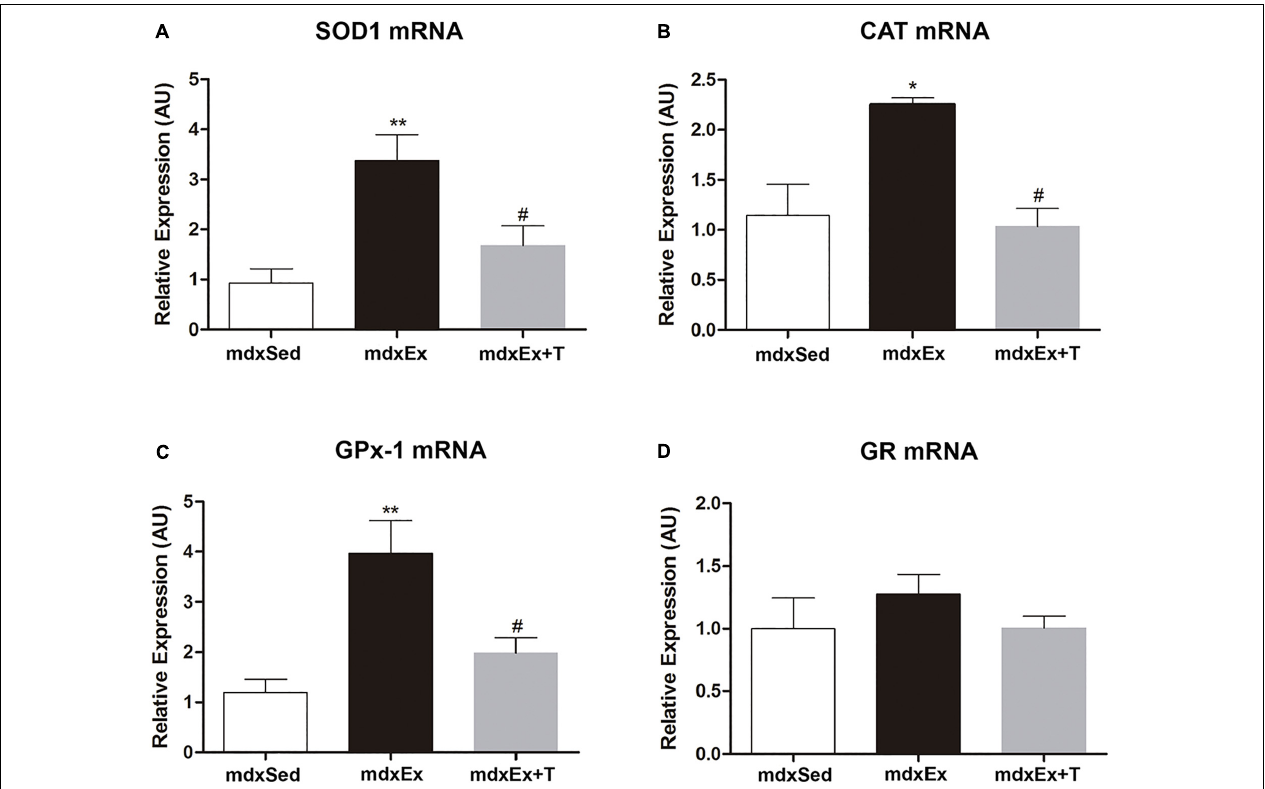
FIGURE 7 | Tempol effects on the enzymatic antioxidant system expression. Gene expression of (A) manganese-superoxide dismutase (SOD), (B) catalase, (C) glutathione peroxidase (GPx), and (D) glutathione reductase (GR) measured by qRT-PCR in the diaphragm (DIA) muscle from the sedentary mdx mice (mdx Sed), exercise trained mdx mice ( mdx Ex), and exercise trained mdx mice treated with Tempol ( mdx Ex+T). All values expressed as mean ± standard deviation (SD). * P ≤ 0.05 compared with the mdx Sed group, ** P ≤ 0.001 compared with the mdx Sed group, # P ≤ 0.05 compared with the mdx Ex group (one-way ANOVA with Tukey’s post hoc test).